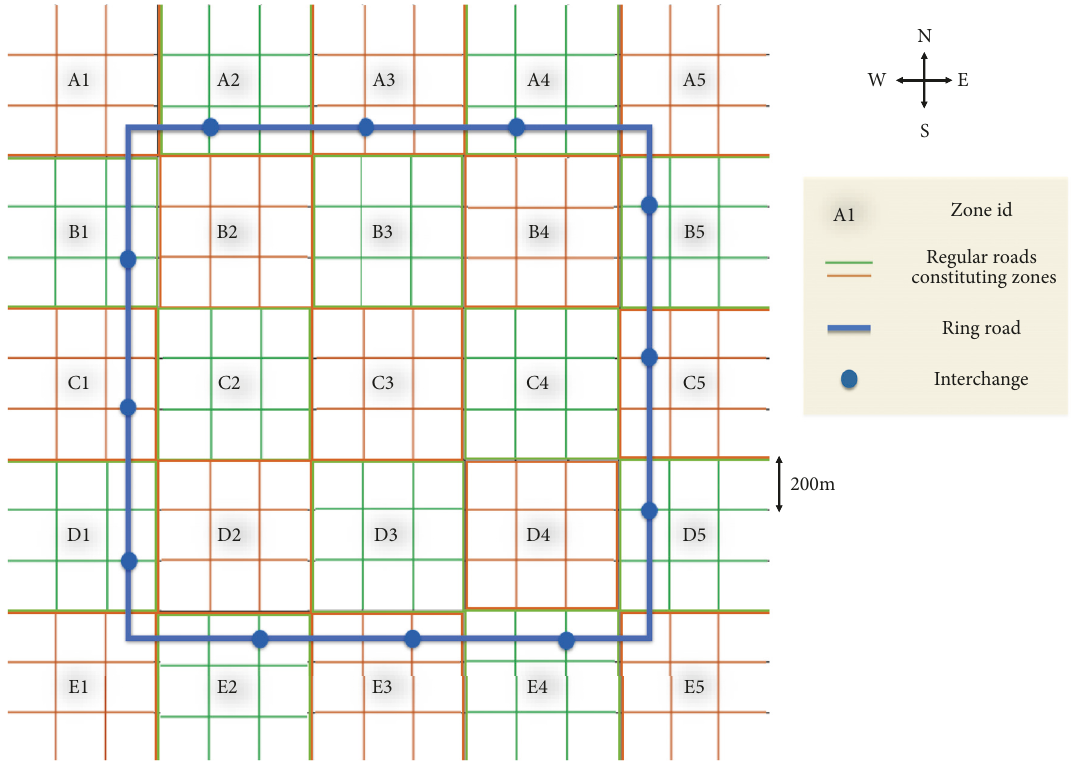
Figure 1: Support network: Manhattan town with ring